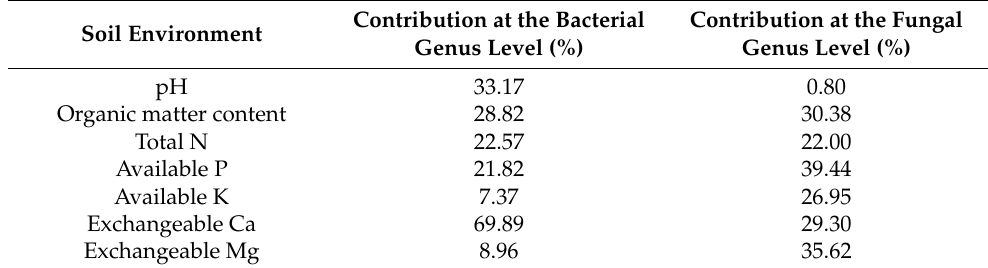
Table 6. Contribution of the soil environment to bacteria and fungi taxa at the genus